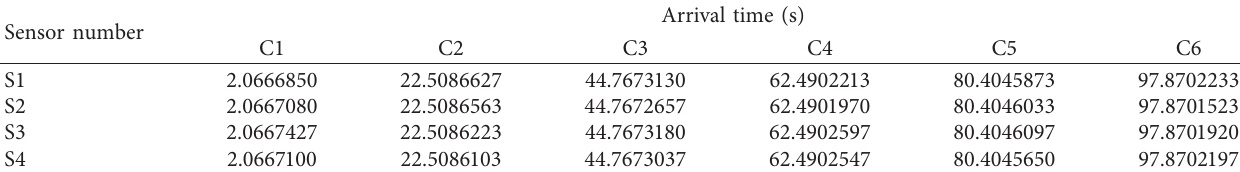
Table 13: First arrival time of the pulse sources for Scheme II of G3761-L.